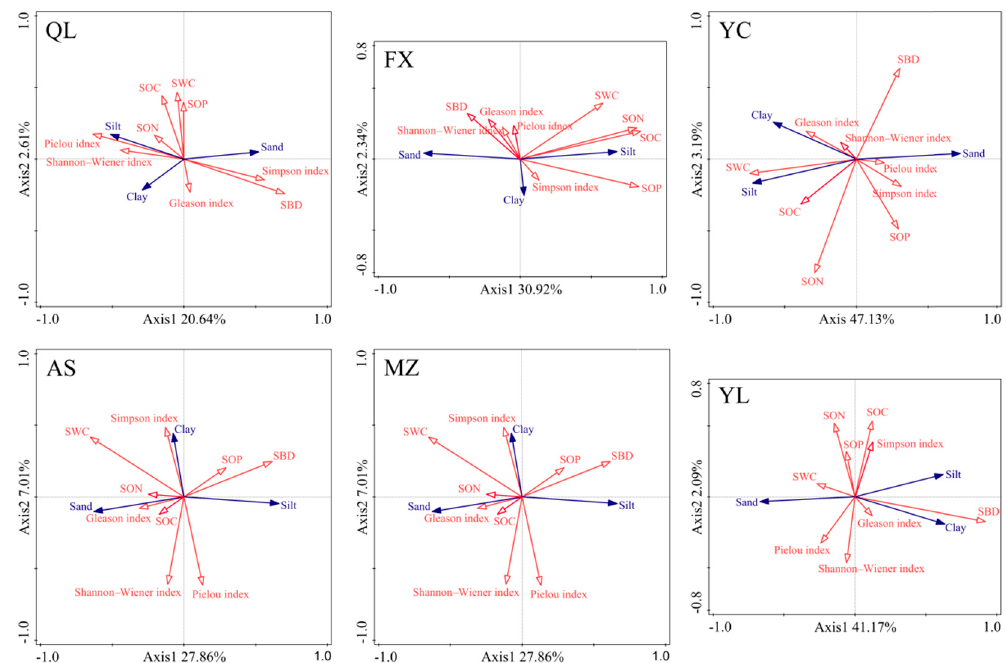
Figure 6. Ordination plots of the results from the redundancy analysis (RDA) to identify the correlations among the PSD (blue arrows), plant characteristics, and soil properties (red arrows) on a local scale. SOC, stock of soil organic carbon; SON, stock of total nitrogen; SOP, stock of total phosphorus.